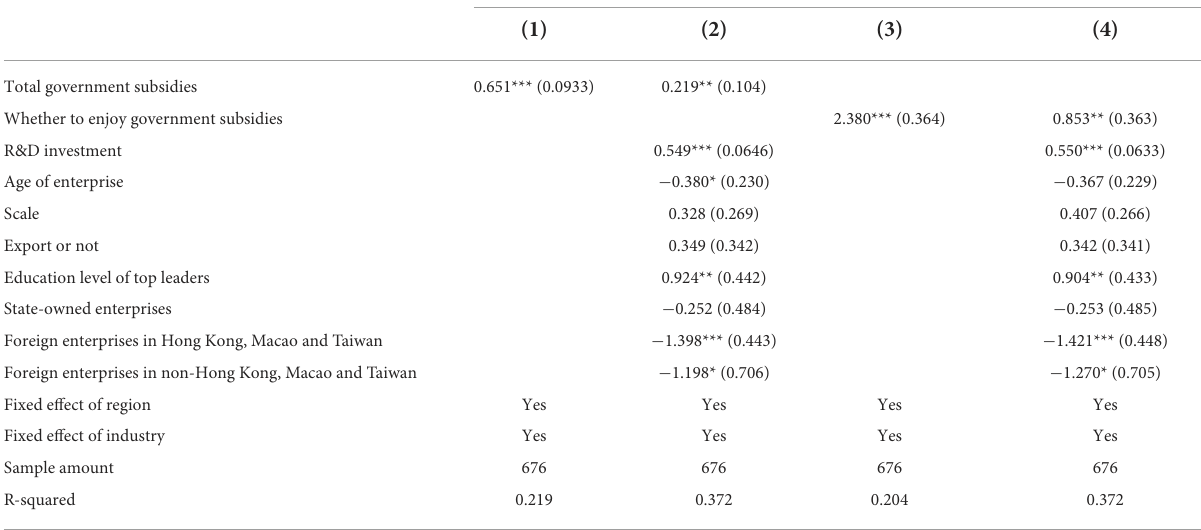
TABLE 2 Impact of government subsidies on enterprise innovative